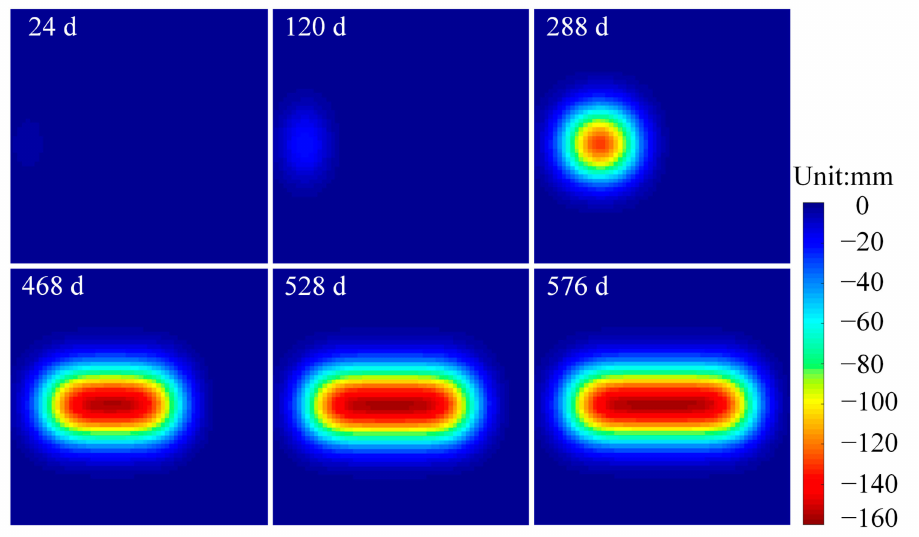
Figure 3. Selected images of simulated settlement field (at 24 d, 120 d, 288 d, 468 d, 528 d, and 576 d,